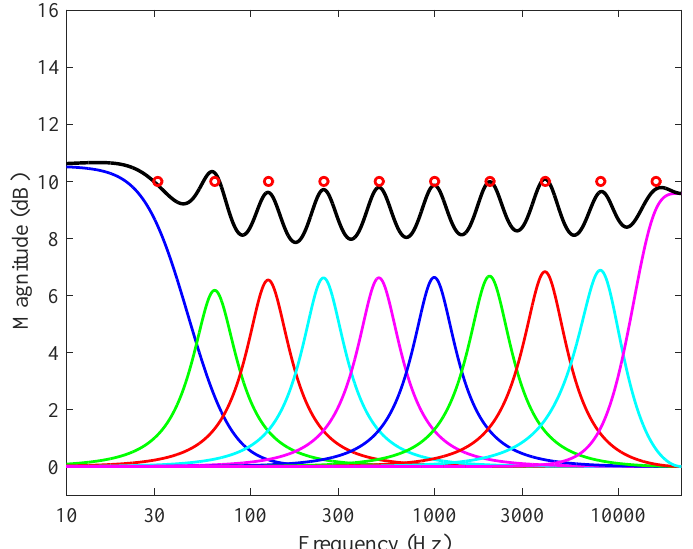
Figure 9. Magnitude response of the cascade graphic equalizer when its filter gains have been solved accounting for the interference between band filters. Note that peak gains of band filters are not the same as command gains (red circles). Cf. Figure